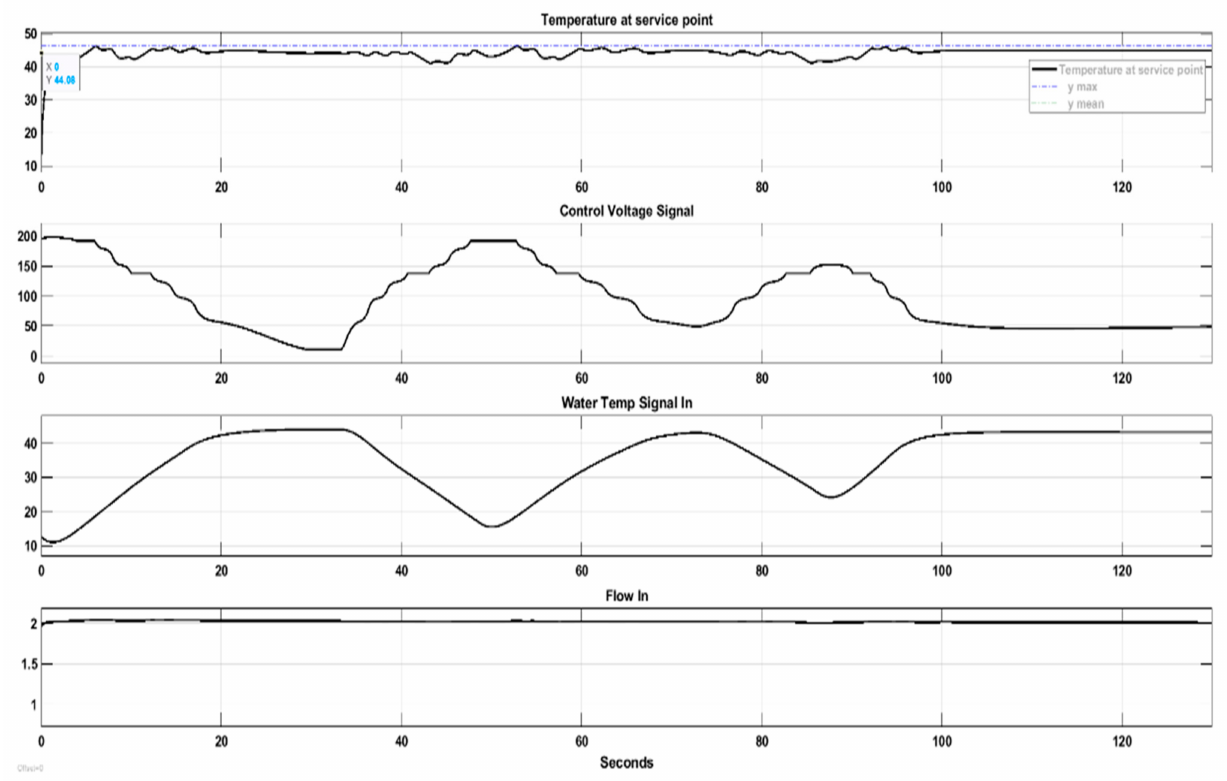
Figure 9. Performance of the fuzzy controller with Central Heater Fluctuation at maximum flow.